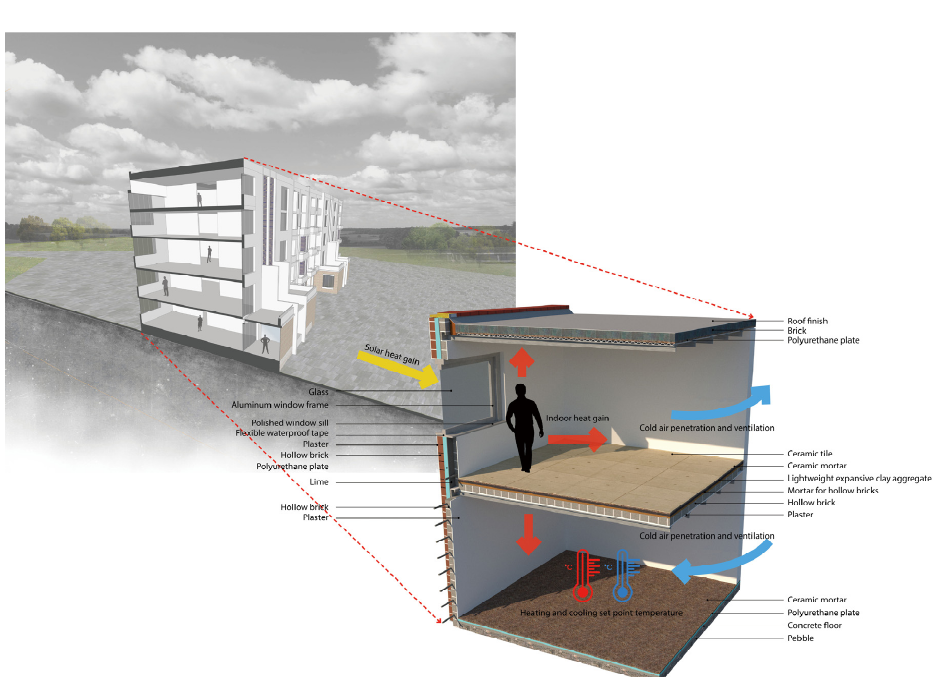
Figure 13. Factors in parametric modeling of residential